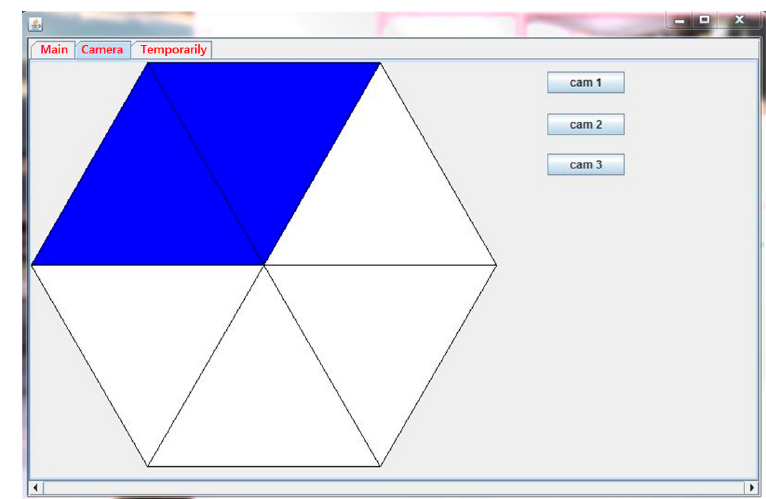
Figure 9. Implementation of The Screen Settings for Camera-based Monitoring Program.